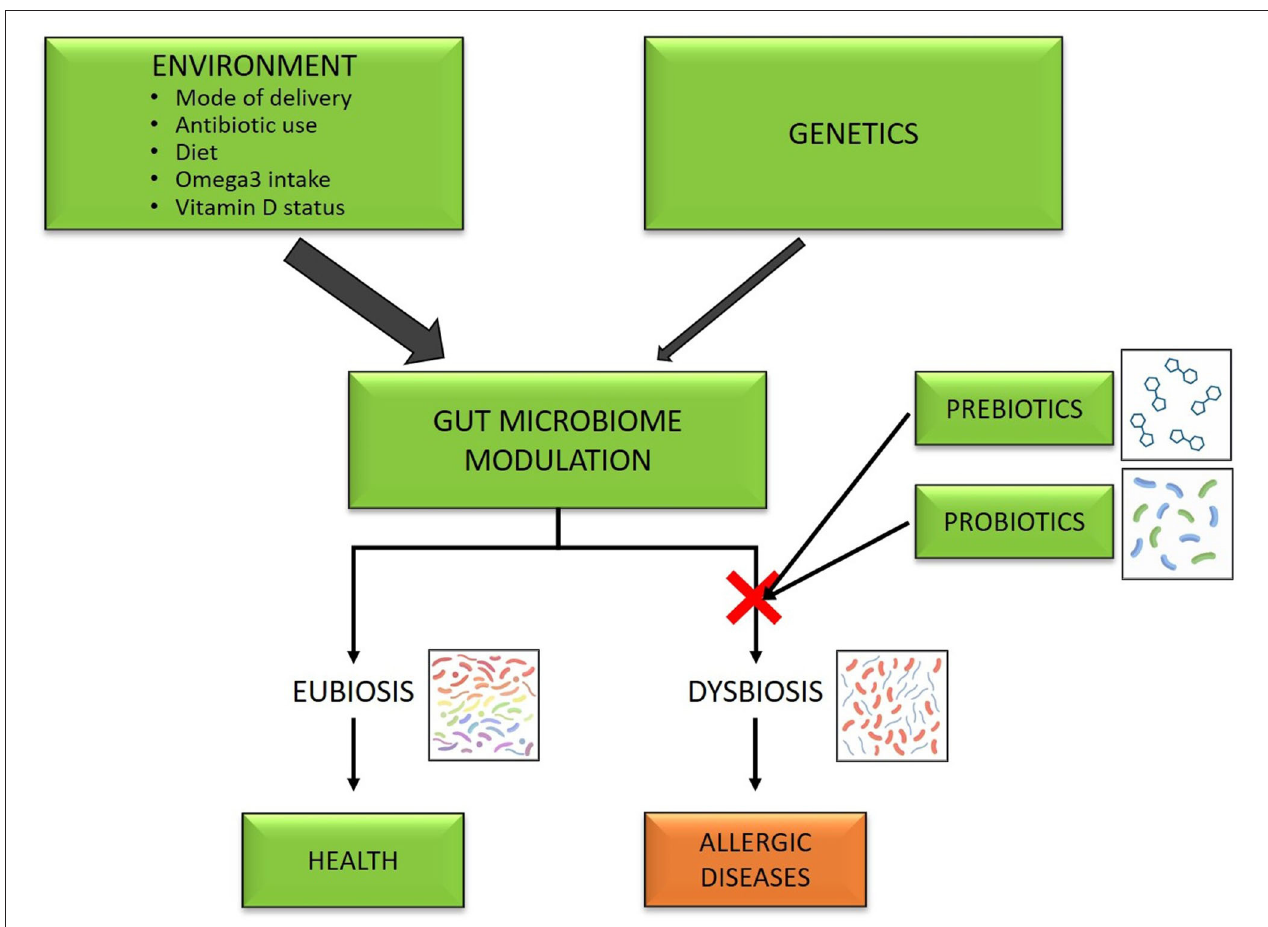
FIGURE 1 | Gut microbiota as a target of prevention of allergic